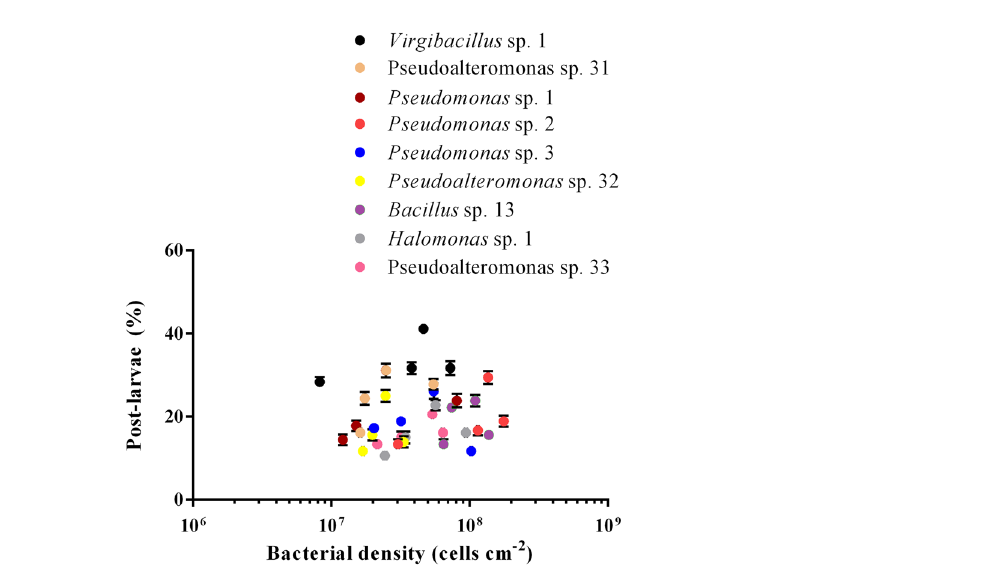
Figure 2. M. coruscus post-larval rates on deep-sea bacterial BFs under dynamic changing densities. Post- larvae rate: Means ± SE (n = 6); bacterial densities: Means ± SE (n =